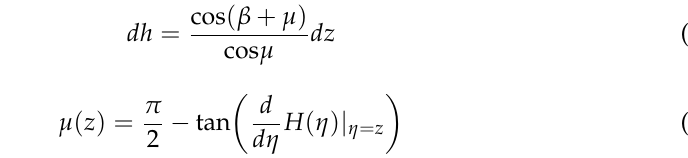
Figure 11. Simplified force characteristics of active pressure.